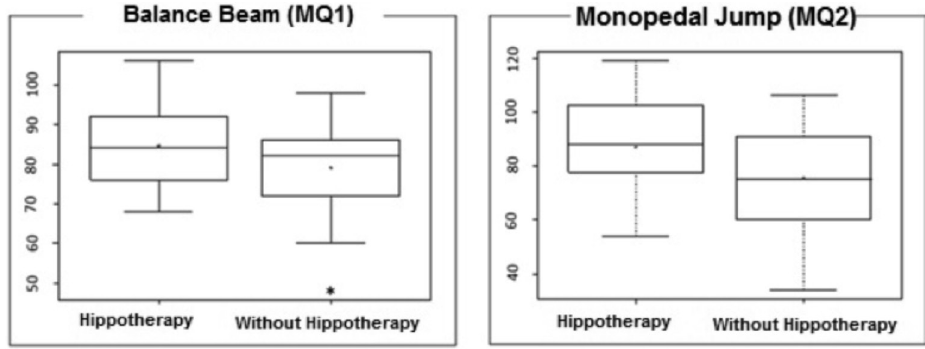
Figure 1 - Boxplot of the variables Balance Beam (MQ1) and Monopedal Jump